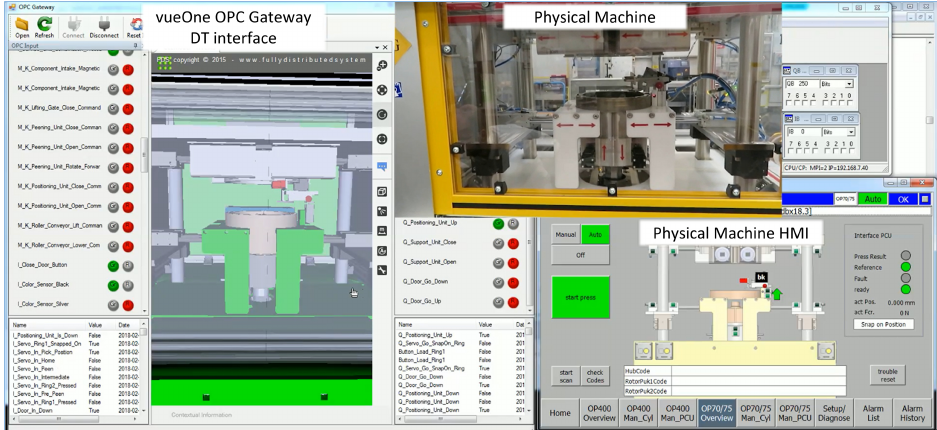
Figure 10. VueOne digital twin connected to the physical